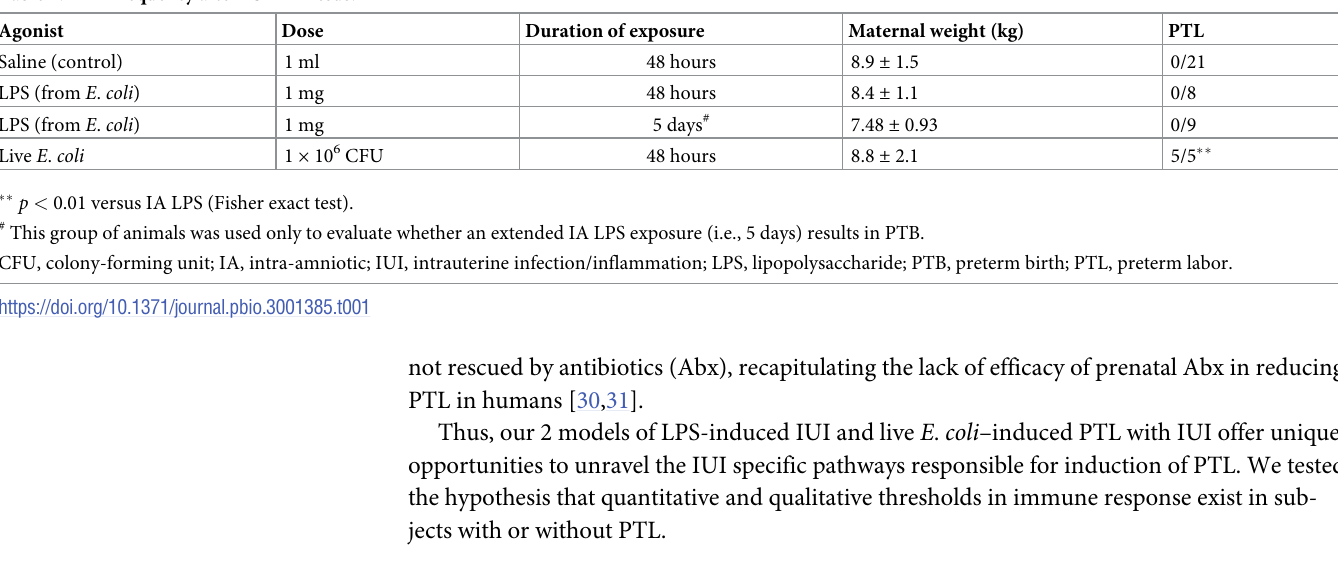
Table 1. PTL frequency after IUI in rhesus.